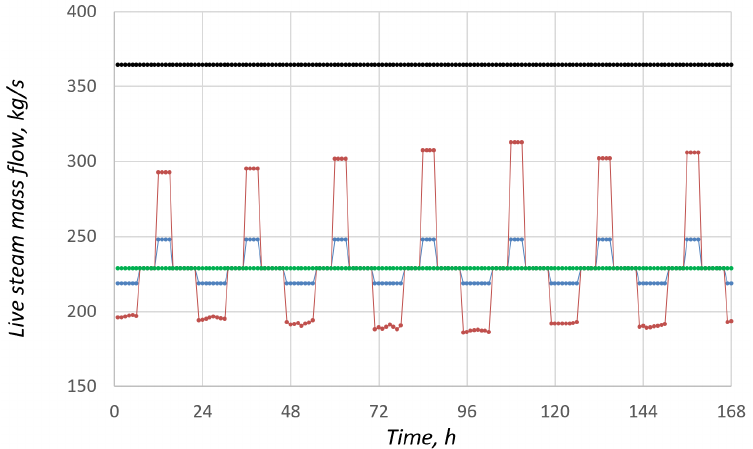
Figure 8. Live steam mass flow as a function of time for first week of reference year (black—REF_3NR, green—REF_2NR, blue—TES25 (200 MWh), and red—TES150 (1200 MWh)).